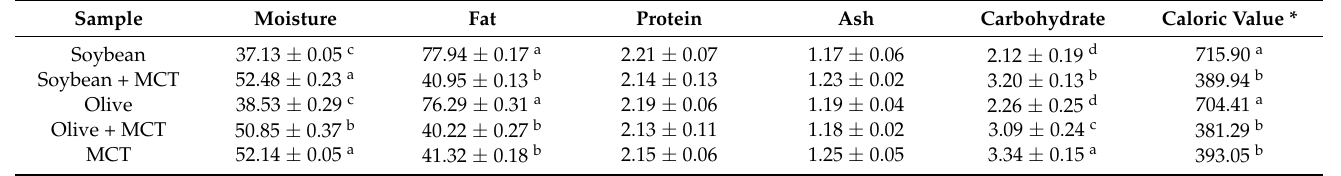
Table 2. Chemical composition analysis (%, w/w ) and caloric values of the mayonnaise samples.